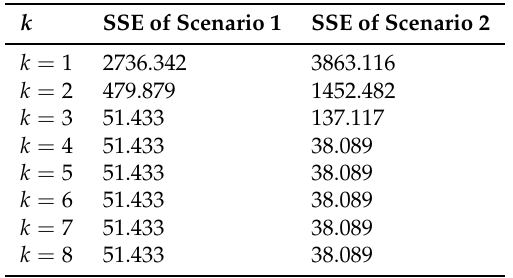
Table 1. Sum of Squared Errors of the data per k in k -means algorithm.